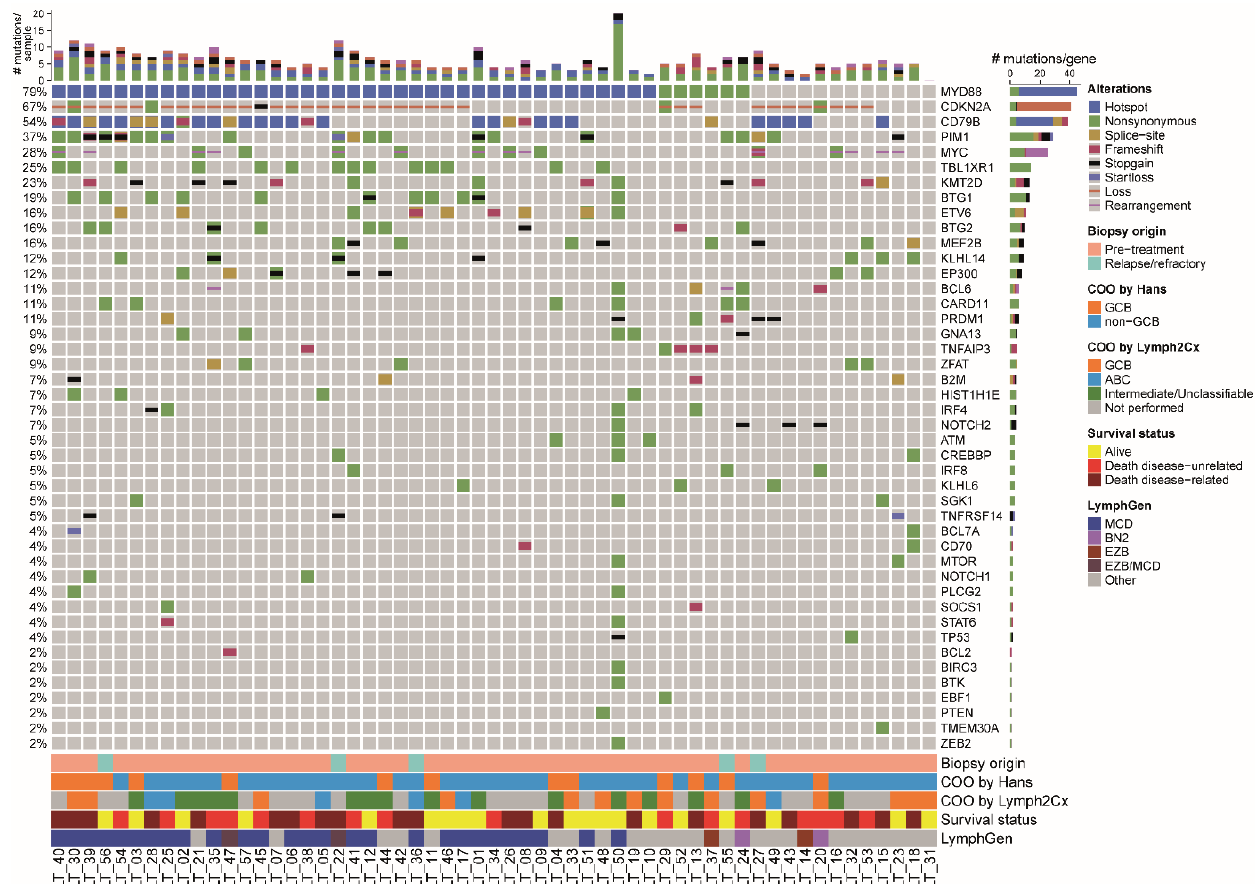
Figure 2. Molecular oncoprintplot of the total cohort of 57 patients with primary cutaneous diffuse large B-cell lymphoma, leg type. The type of alteration of each gene (rows) is visualized per patient (columns). The top bar chart shows the number of mutation types per patients and the right bar chart shows the number of alterations per gene. Biopsy origin (pre-treatment or relapsed/refractory disease), cell-of-origin status as determined by the Hans’ algorithm with immunohistochemistry or Lymph2Cx with NanoString, survival status, and estimated LymphGen classification are presented at the bottom. The most frequent alterations were mutations in MYD88 and CD79B , especially the hotspots L265P and Y196, respectively, and loss of CDKN2A . In 95% of patients, at least one of these three abnormalities was present.